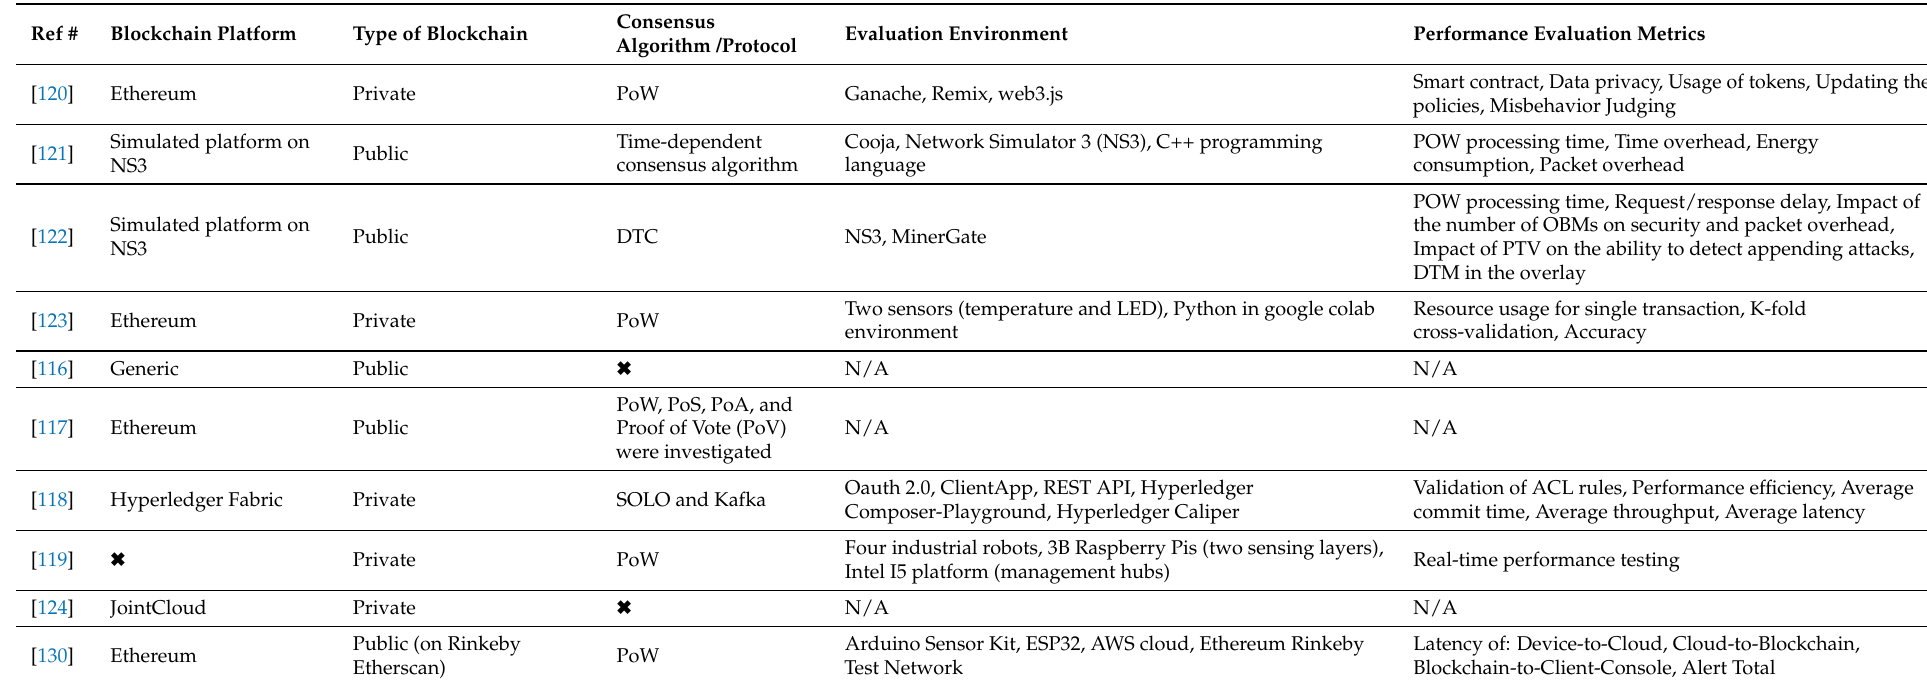
Table 5. Smart Environments Articles: Blockchain Characteristics, Evaluation Environment, and